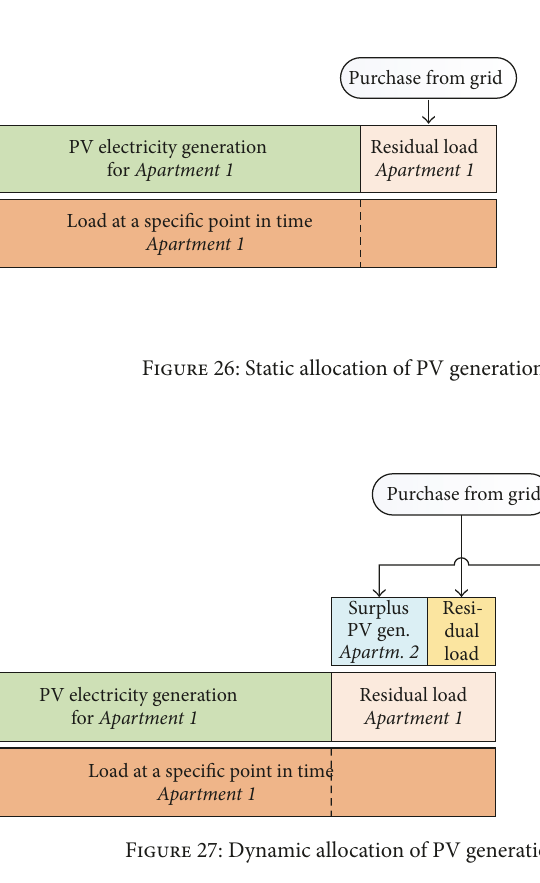
topic for residents participating in shared PV